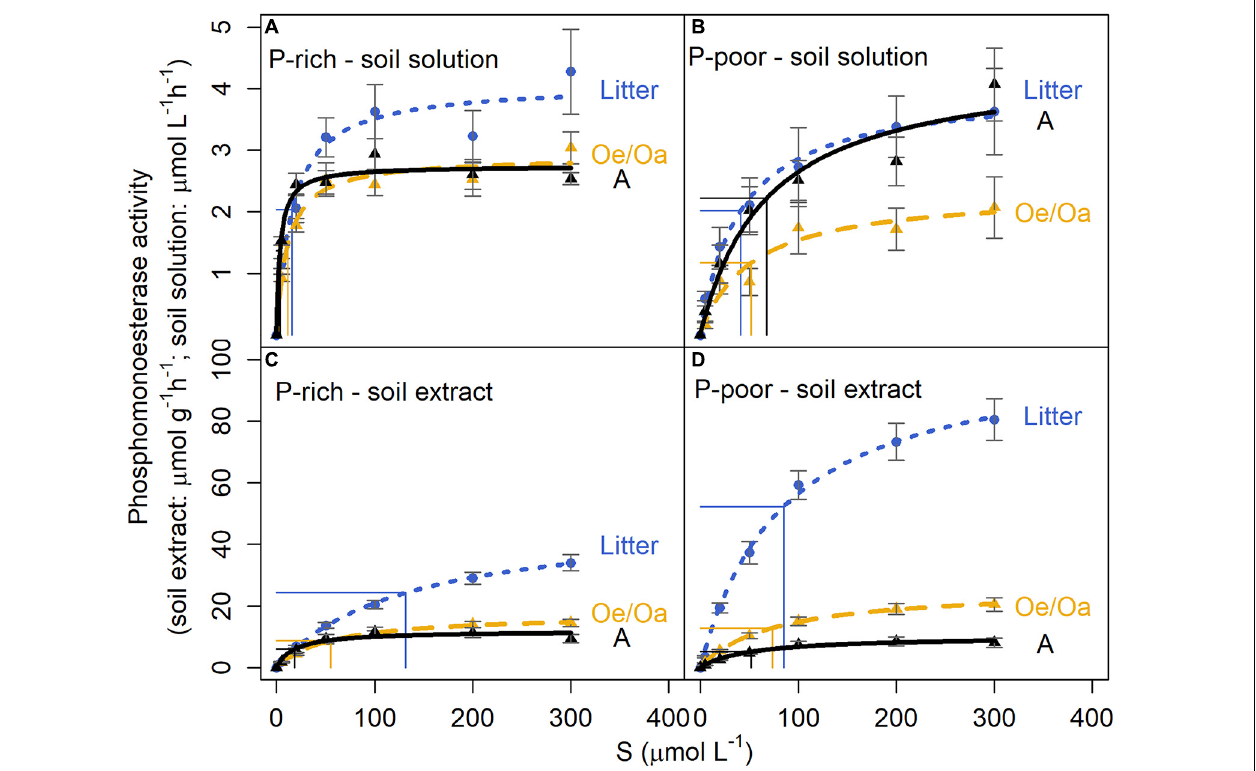
FIGURE 3 | Reaction rates of phosphomonoesterase in leached soil solutions and soil extracts from litter, Oe/Oa, and Ah horizons at the P-rich site Bad Brückenau (BBR) and the P-poor site Lüss (LUE) as dependent on substrate concentration (S). (A) Phosphomonoesterase activity in leached soil solutions from BBR; (B) Phosphomonoesterase activity in leached soil solutions from LUE; (C) Phosphomonoesterase activity in soil extracts from BBR; (D) Phosphomonoesterase activity in soil extracts from LUE. Horizontal lines are half potential activity (V max ) and vertical lines the Michalis-Menten constant K M . Symbols = experimental data, lines = approximation by Michaelis-Menten kinetics. Data from July 2019. Error bars as standard error ( n = 12, averaged over all fertilization treatments).